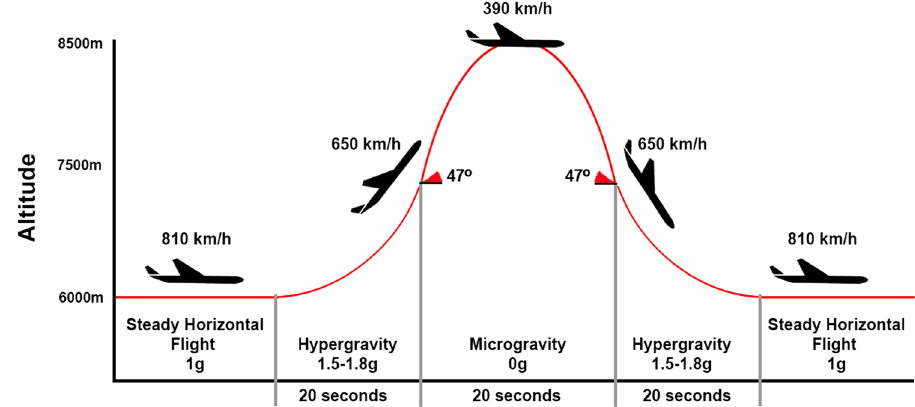
Fig. 1 Typical fl ight trajectory of a PF for 0 g parabola ’